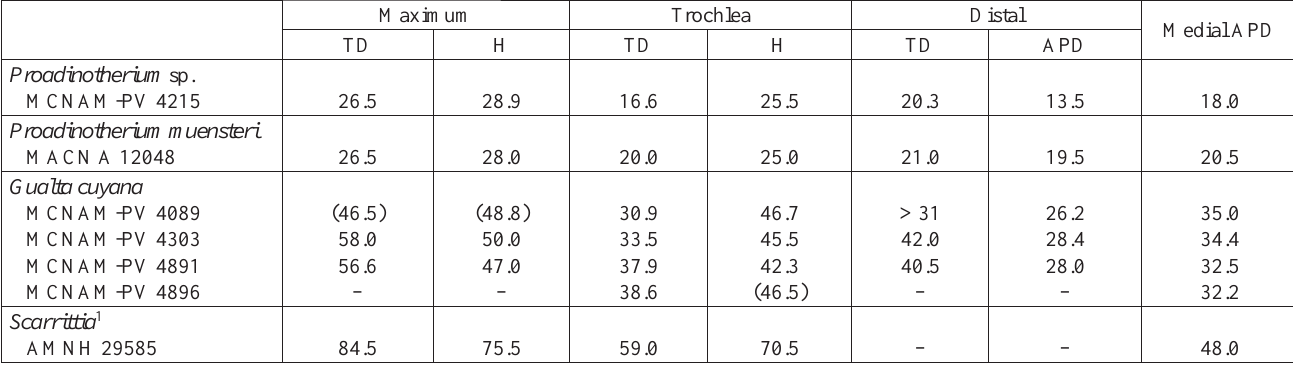
Table 2. Comparative measurements (in mm) of the astragali of Proadinotherium sp. and Gualta cuyana from Quebrada Fiera, Mendoza. 1 photo- graphs of Scarrittia taken by Barbara Vera and Andrea Elissamburu. Values in parentheses are approximate. APD, anteroposterior diameter; H, height; TD, transversal diameter; – measurement not available.